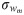
Comparison of log-averaging and Kalman filtering using (a) N = 3 and (b) N = 10 simulated replicates under log-normal noise model.The vertical axis represents the data domain ground truth reactivity, sm. The horizontal axis represents the log domain standard deviation of the simulated measurements, σwm. Nucleotides were binned based on sm and σwm values. Left panel shows RMS errors calculated between ground truth and log-averaged reactivities for all nucleotides in a bin. Right panel shows RMS errors calculated between ground truth and Kalman filtered reactivities for all nucleotides in a bin. Error calculations were carried out in the log domain and ground truth values were the log reactivities. See Methods for RMS calculation details.